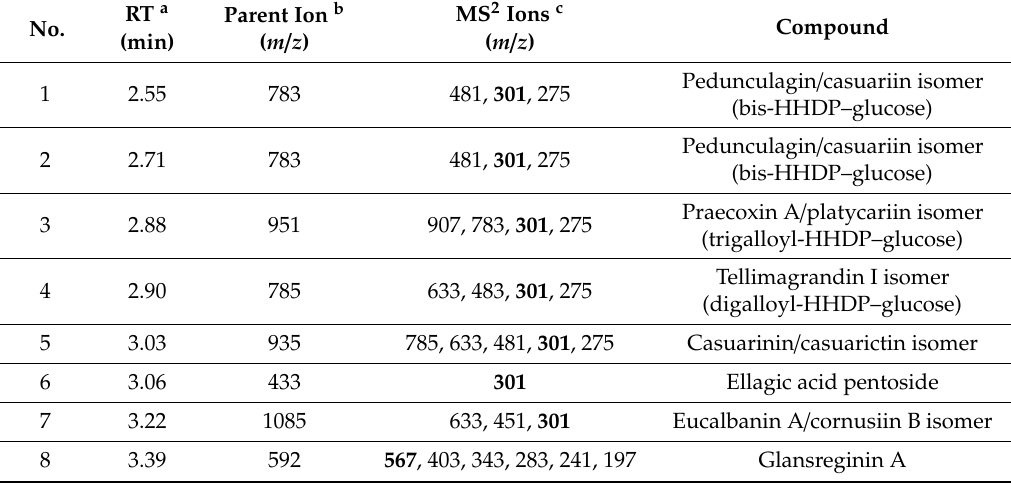
Figure 2. Ultra-performance, liquid chromatography–ion mobility separation–quadrupole time of flight / tandem mass spectrometry (UPLC Q-TOF / MS 2 ) chromatographic profile of walnut extract. Table 2. Compounds identified from walnut ( Juglans regia L.) extract.